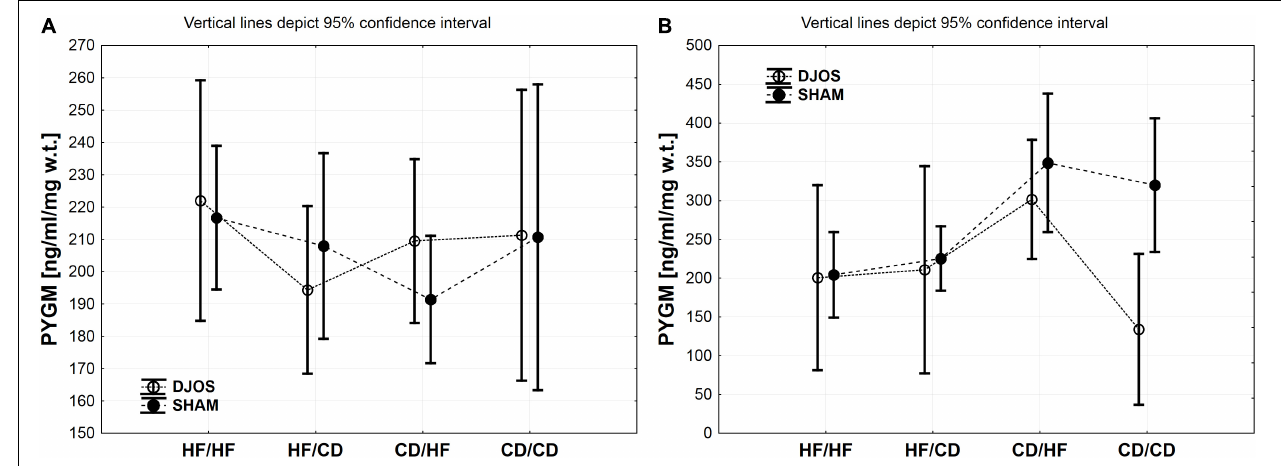
FIGURE 4 | (A) PYGM (ng/ml/mg w.t.) muscle concentration in groups subjected to different dietary patterns, according to the DJOS and SHAM operation type. (B) PYGL (ng/ml/mg w.t.) liver concentration in groups subjected to different dietary patterns, according to the DJOS and SHAM operation type. Statistical significance was set at a p < 0.05. Vertical lines depict 95% confidence interval. DJOS, duodenal-jejunal omega switch surgery; HF, high fat diet; CD, control diet; HF/HF, CD/HF, HF/CD, CD/CD, type of diet 8 weeks before/8 weeks after